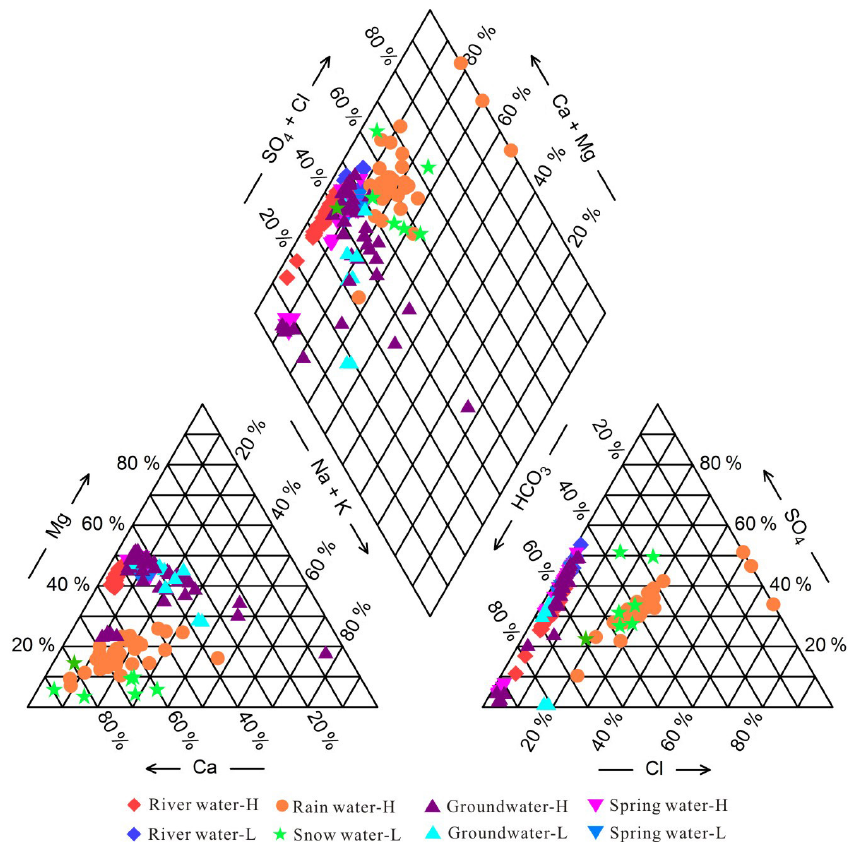
Figure 6. The piper diagram for groundwater, stream water, precipitation, and glacier and snow meltwater in the study area. “H” refers to high flows in the warm season; “L” refers to low flows in cold season. Table 2. The 3 H, 13 C and 14 C isotopic composition of groundwater samples and 14 C ages corrected using the δ 13 C-mixing model modified by Clark and Fritz (1997); “n.d.” means not determined, and “n.c.” means not